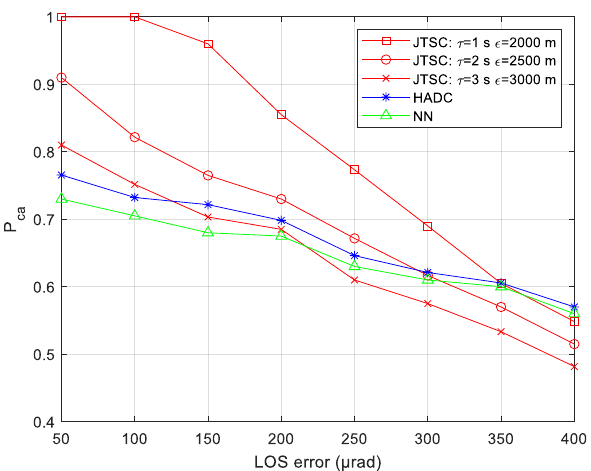
Figure 11. Probability of correct association vs. different LOS errors.